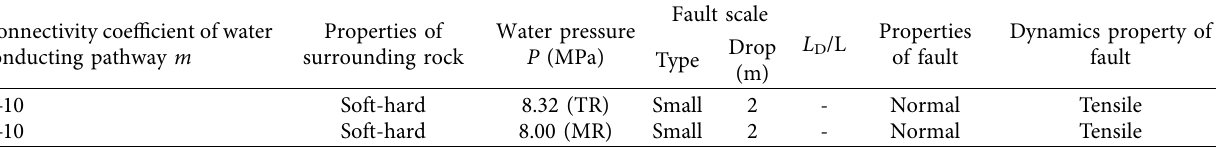
Table 5: Connectivity coefficients of water conducting pathway of faults in surrounding rock of Panel No. 21102. Connectivity coefficient of water conducting pathway m